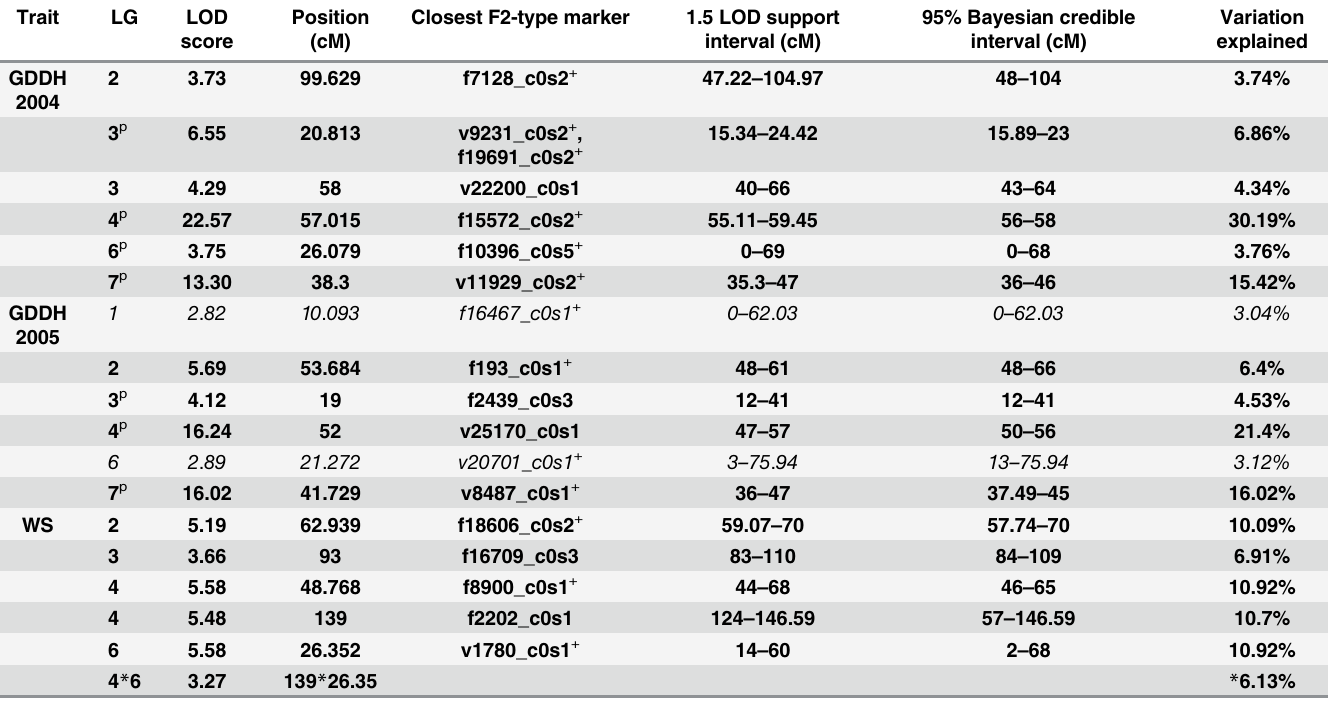
* Interaction between the second QTL on LG4 and the QTL on LG6 (p < 0.01). + marker located at the QTL signal peak.